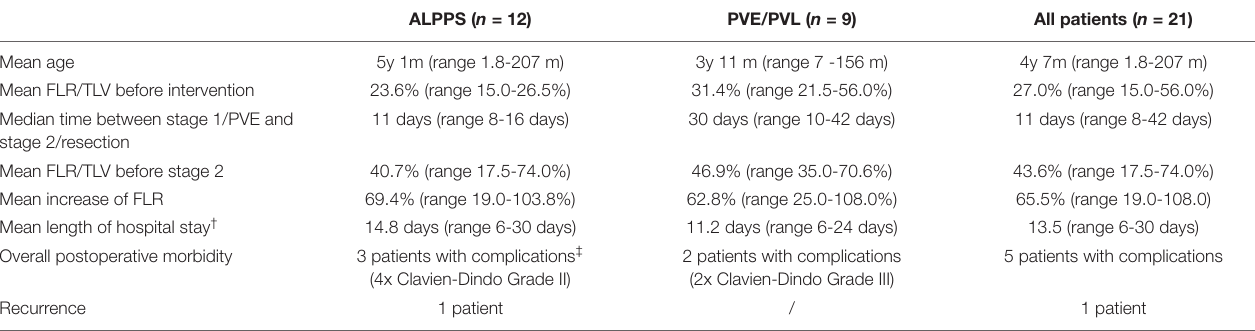
TABLE 4 | Patient characteristics and data on FLR.